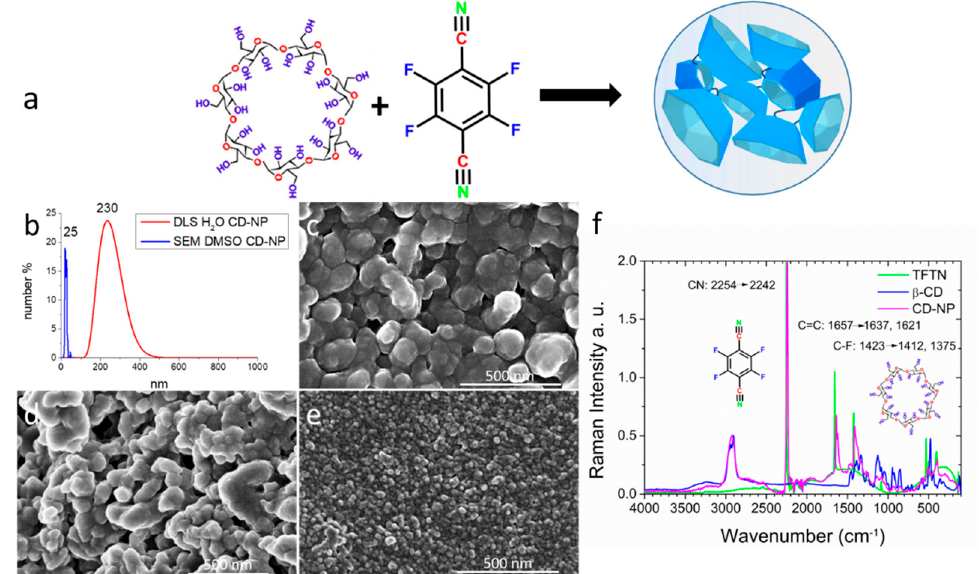
Figure 1. ( a ): reaction scheme of cyclodextrin and TFTN to form CD-NP. ( b ) Particle size distribution of CD-NP as determined by DLS in an aqueous solution (red, PDI = 0.26) contrasted to the size distribution of the identical sample as determined from SEM micrographs (blue) when stirred in DMSO, data taken from SEM in ( e ). ( c , d ) are typical SEM pictures made from an aqueous ( c ) or ethanolic ( d ) CD-NP solution showing agglomerated particles of sizes similar to those measured by DLS. ( f ) FT-Raman spectra of the precursor CD (blue), TFTN (green) and the final CD-NP (purple). Frequency shifts of TFTN in CD-NP as compared to the precursors are indicated.